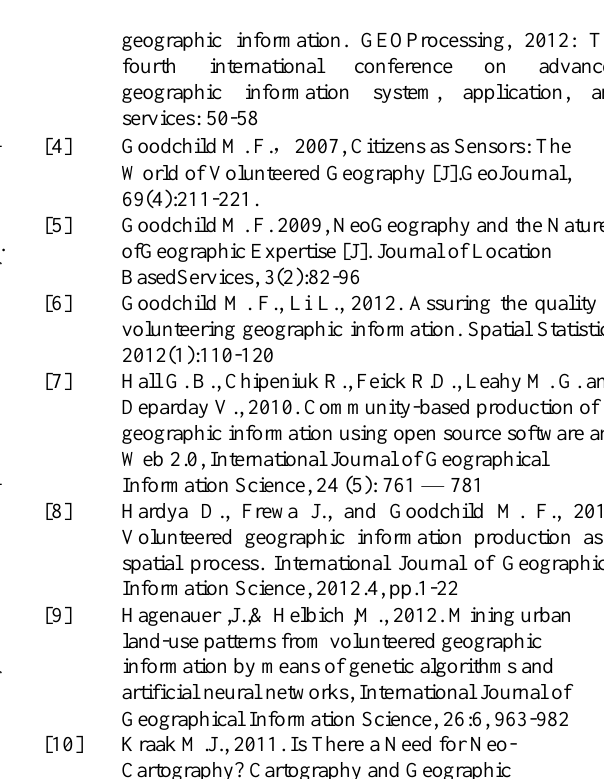
Figure 5 The changed roads (red color) of Vientiane extracted from OSM daily diff from May forth to sixth July,